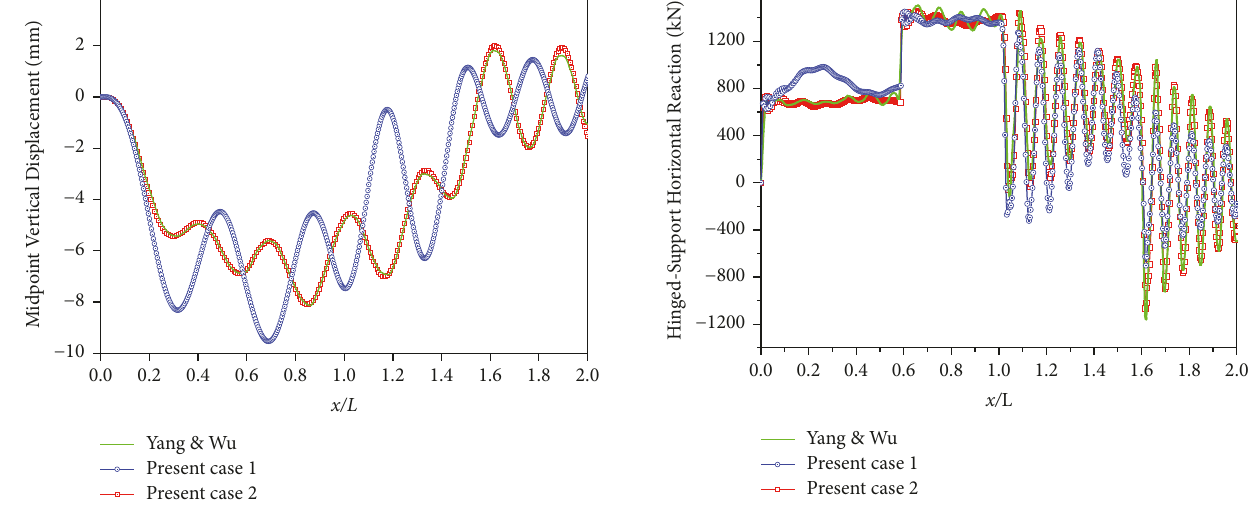
Figure 7: Horizontal reaction at hinged support.